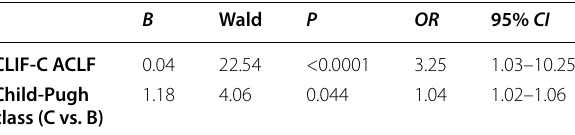
Table 5 Cox regression for the independent predictors of in‑hospital